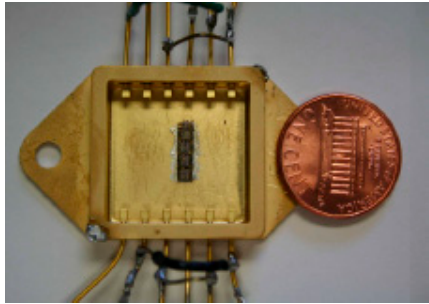
Figure 16. An optical photo for 4H-SiC power integrated circuit after